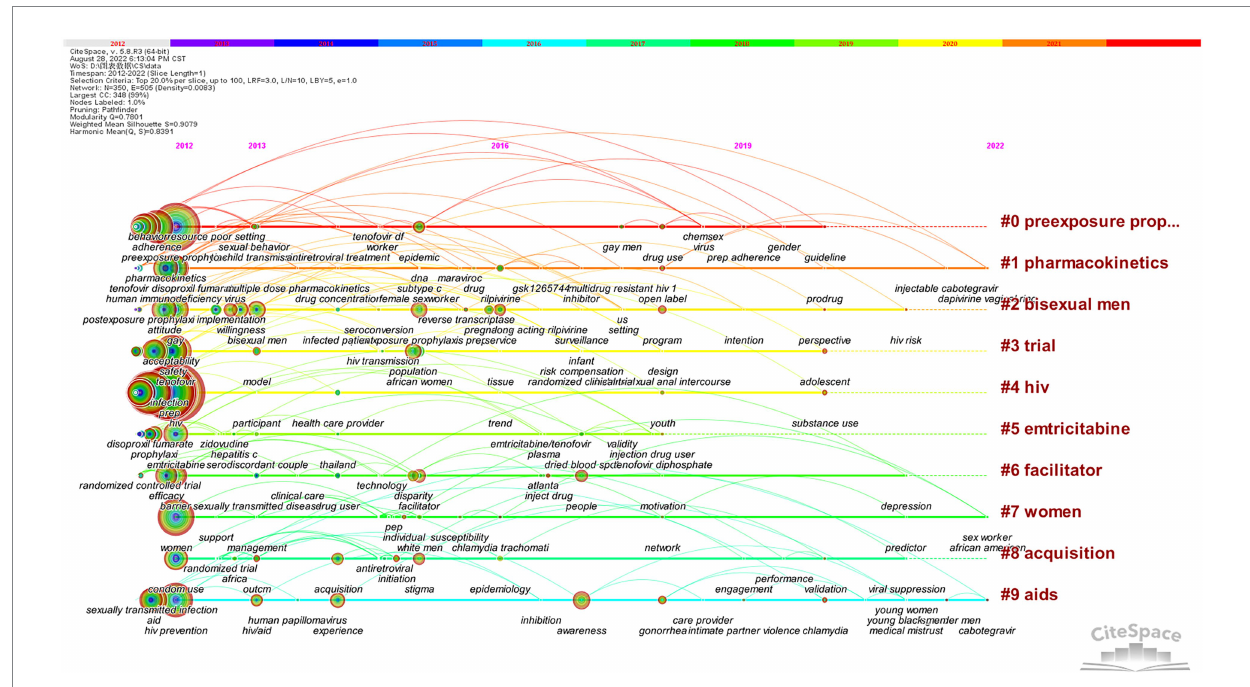
FIGURE 9 Timeline view of the keyword co-occurrence map.